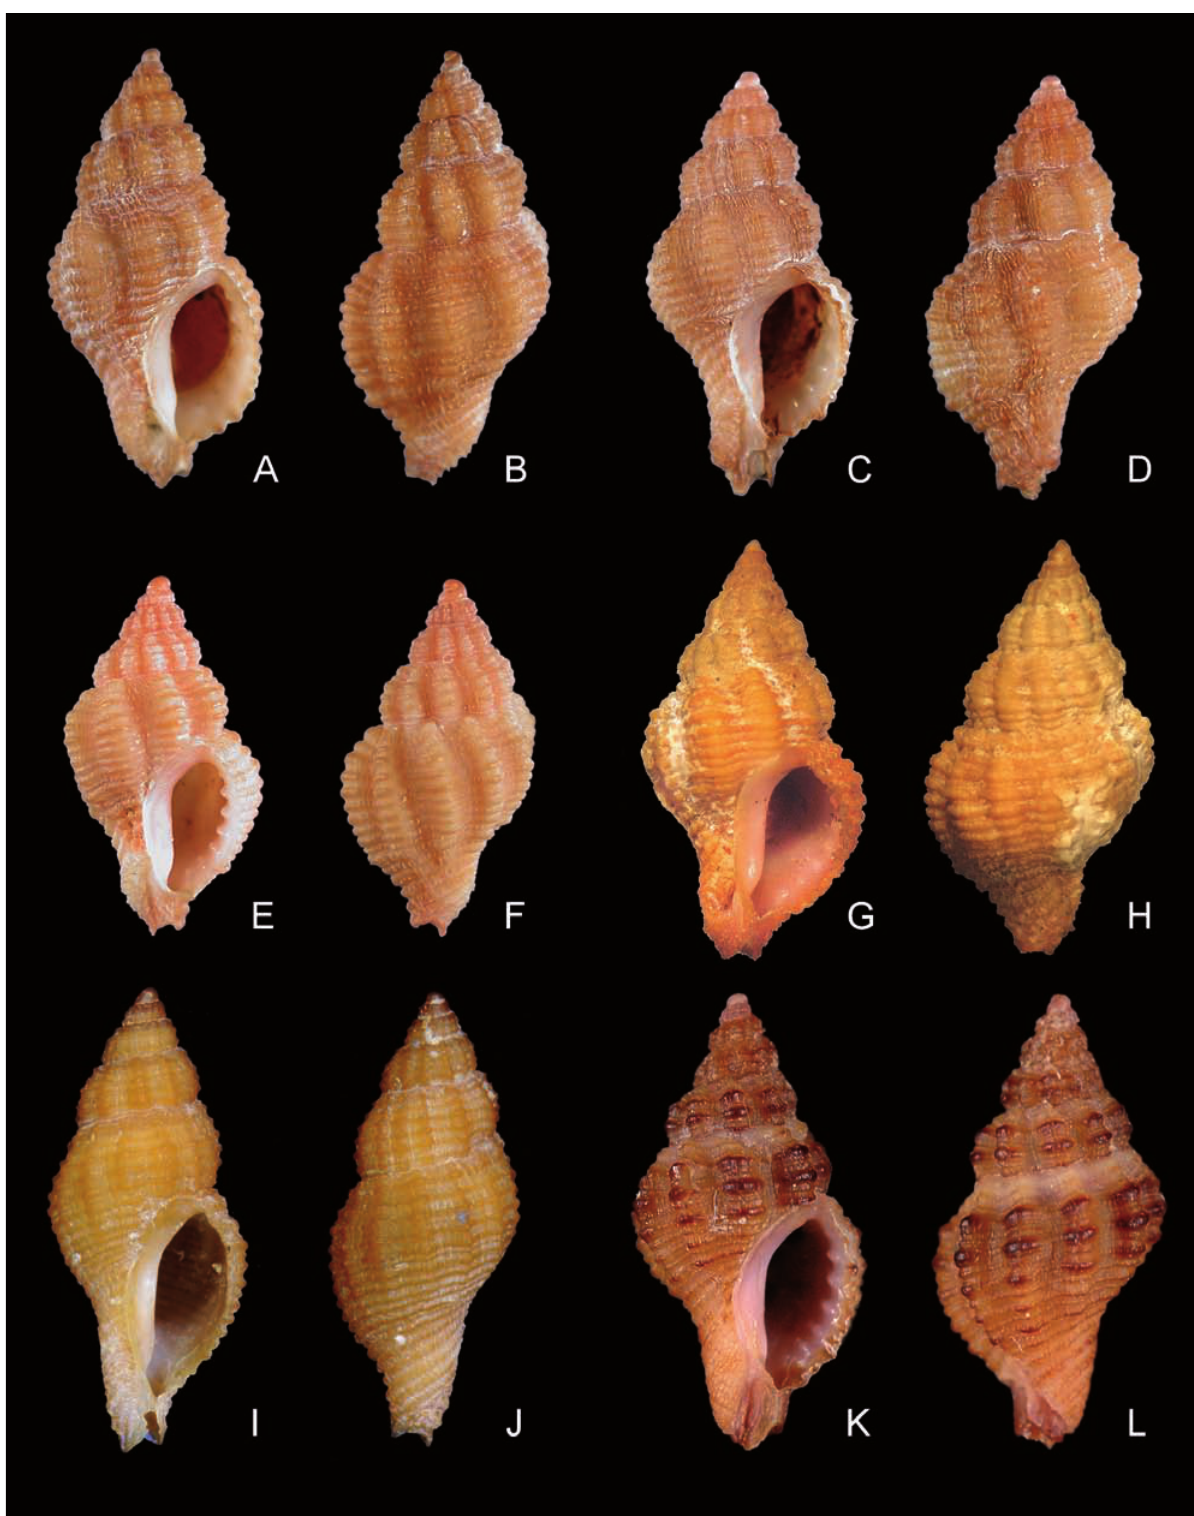
Fig . 1. – Shells of species of the Ocinebrina aciculata complex . A, B, O. aciculata , Erquy, Brittany, France (height 15.8 mm), RHP; C, D, O. aciculata , Fuengirola, Spain (height 11.1 mm), RHP; E, F, O. aciculata , Siracusa, Sicily, Italy (height 8.7 mm), RHP; G, H, O. aciculata , Scacchetiello, Baia, Naples, Italy (height 11.9 mm), neotype of Murex corallinus Scacchi, MZN Z7010; I, J, O. corallinoides , Sfax, Tunisia (height 9.6 mm), holotype of O. aciculata exilis Houart, MNHN 0362; K, L, O. reinai n. sp., Procida Island, Naples, Italy, holotype (height 9.9 mm), MNHN